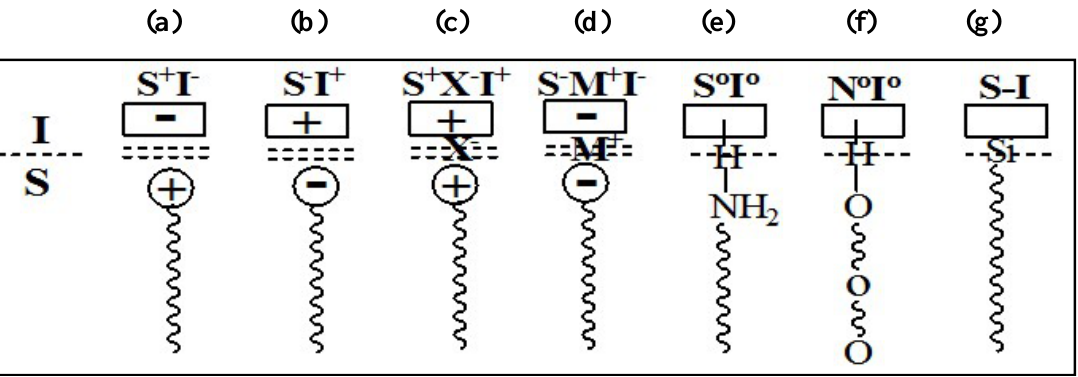
Figure 10. Schematic representation of the different types of silica-surfactant interfaces. S represents the surfactant molecule and I, the inorganic framework. M + and X − represent the corresponding counterions. Solvent molecules are not shown, except for the I°S° case (triangles); dashed lines correspond to H-bonding interactions